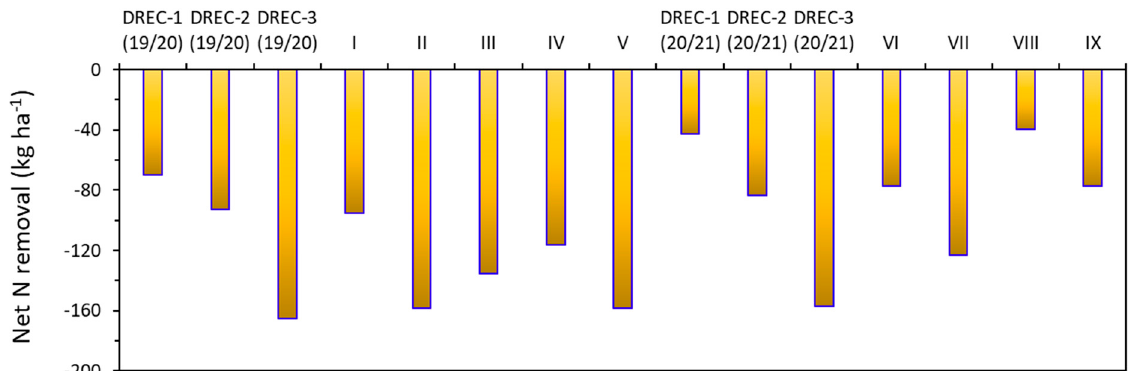
Figure 11. Net N removal at the experimental sites at harvest. Net N removal was calculated as total N accumulated in the roots at harvest minus easonal N applied.